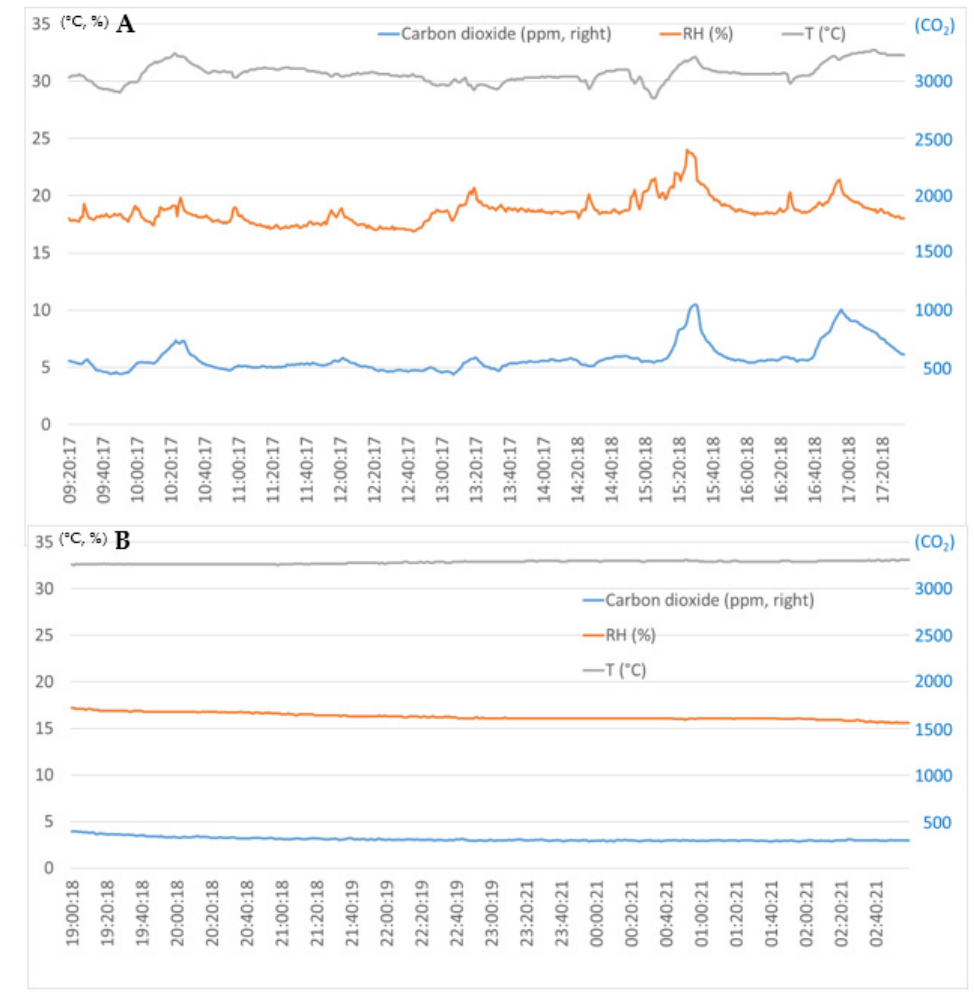
Figure 5. Time course of CO 2 , temperature, and relative humidity. Scale for temperature (in °C) and for relative humidity (in %) is on the left, for CO 2 (in ppm) on the right axis. ( A ): example from a school on a week-day from 10 a.m. until 6 p.m. ( B ): example from another school at night from 7 p.m. till 3 a.m.